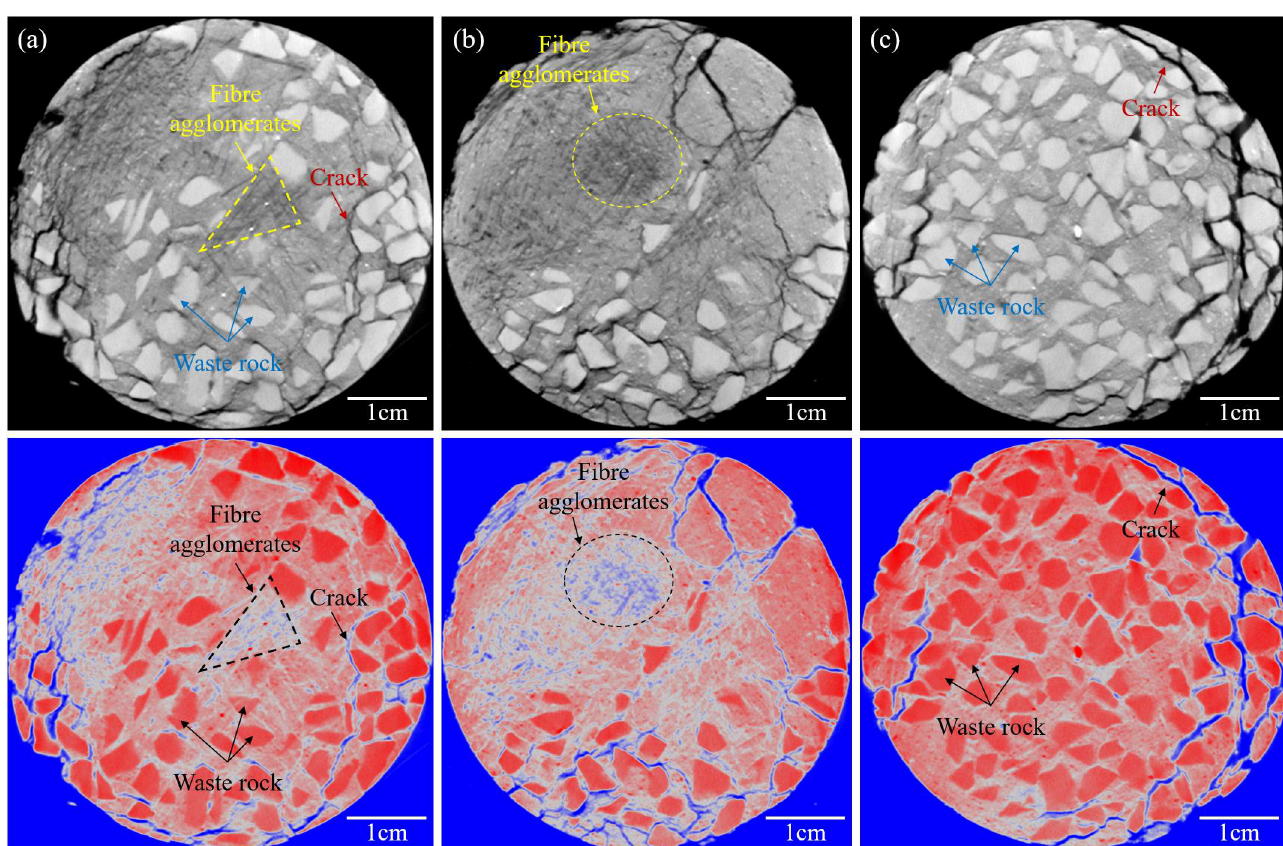
Figure 6. 2D CT images of PP12-0.6: ( a ) Z = 80 mm; ( b ) Z = 50 mm; ( c ) Z = 20 mm.